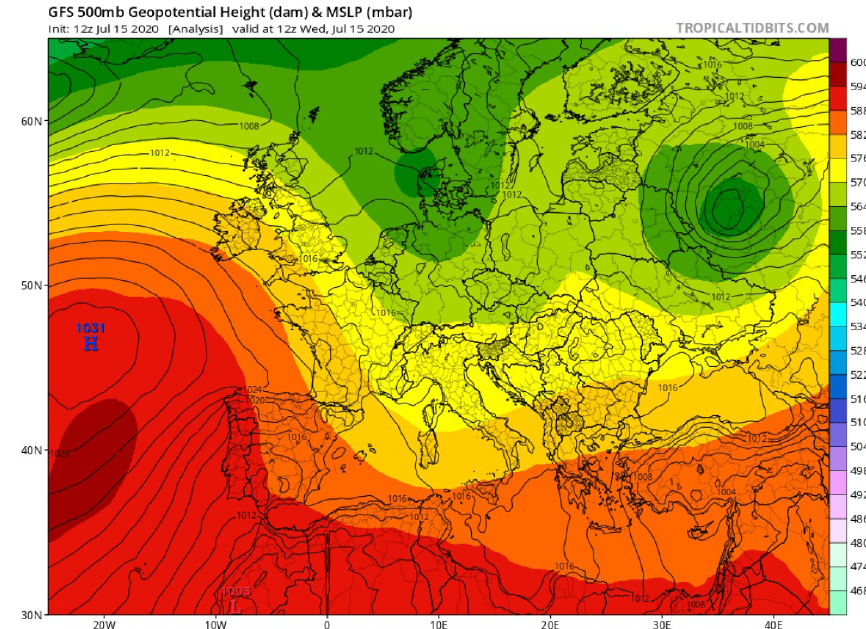
Figure 6. Geopotential heights at the 500mbar level (12z GFS) and mean sea level pressure (MSLP). Colored scale bar indicates the geopotential height values in dam (i.e., decameter), while black contour lines indicate MSLP in mbar (i.e., millibar). Source: NCEP